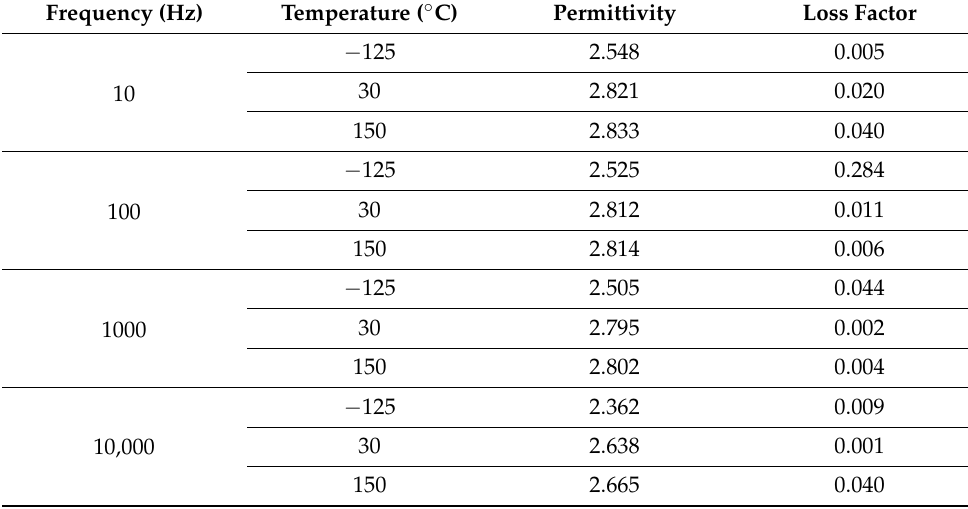
Table 8. Permittivity and loss factor of cured resin at 10, 100, 1000 and 10,000 Hz, and − 125, 30 and 150 ◦ C at BP:B10 = 1:1.